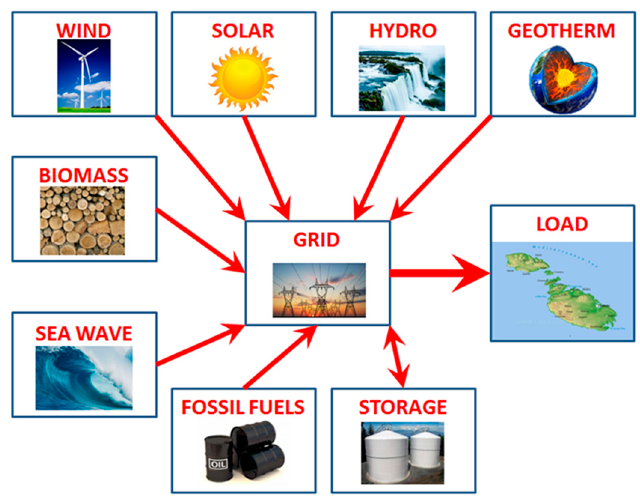
Figure 1. Electrical grid with main RES and storage systems.